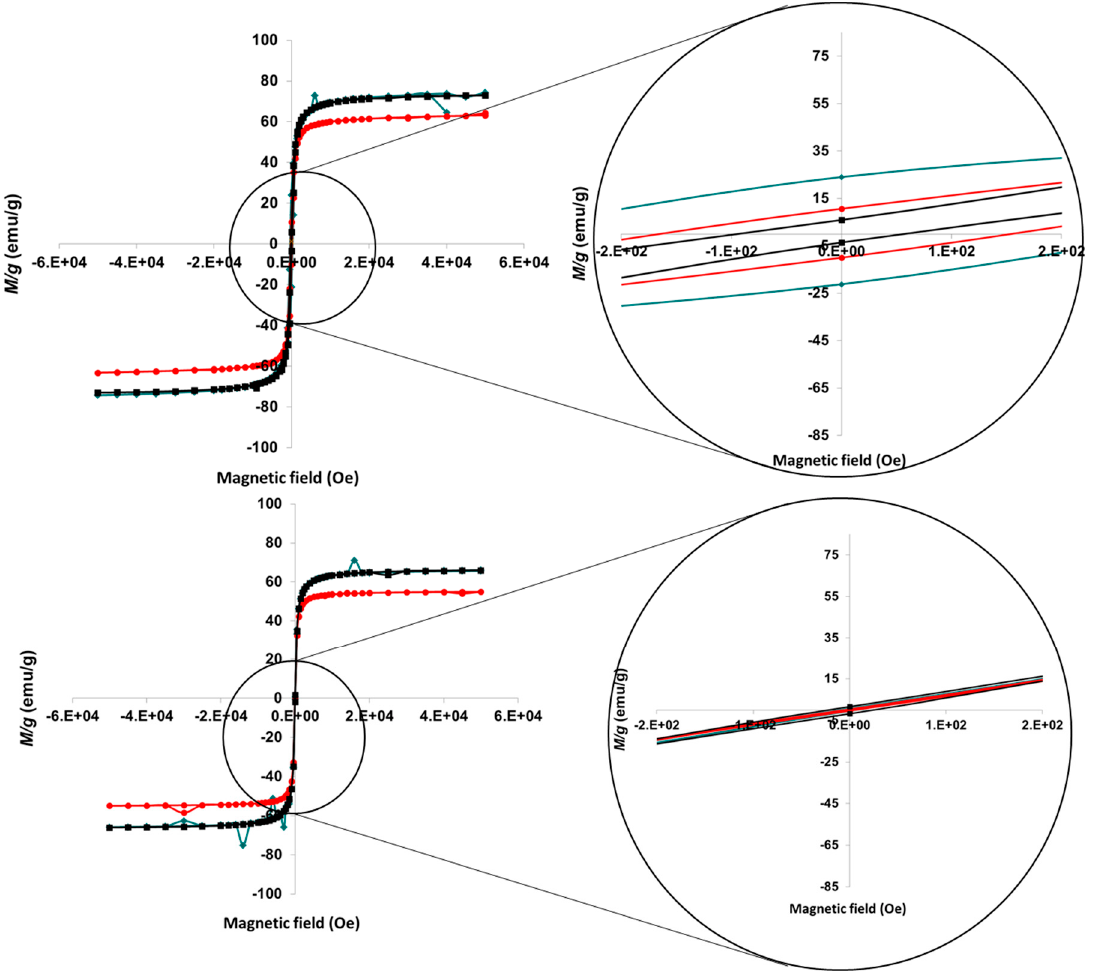
Figure 3. Magnetization cycles of MNPs ( ■ ), BMNPs ( ● ), and 25 B + 75 M ( ♦ ) at 5 K ( top ), and 300 K ( bottom ). Magnifications of the low-field region are also plotted.